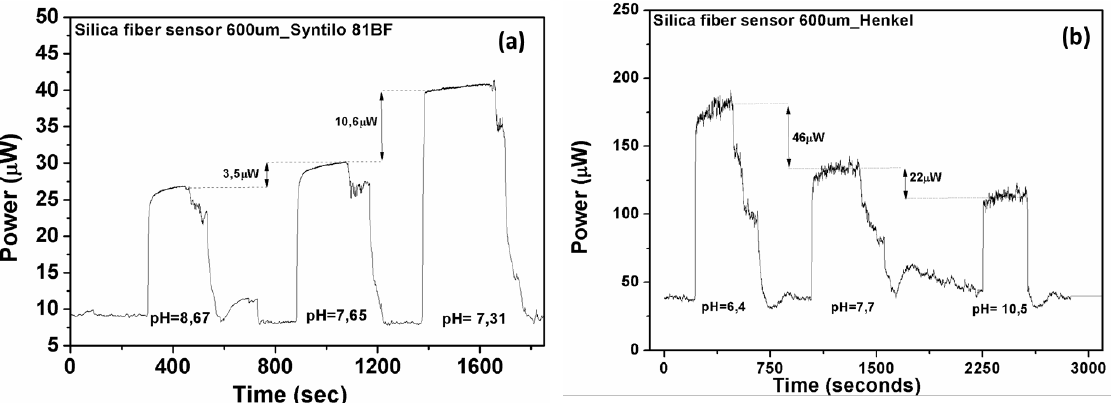
Figure 10. Measured optical response of silica optical fiber based sensor in both coolants ( a ) Castrol Syntilo and ( b ) Henkel Multan.